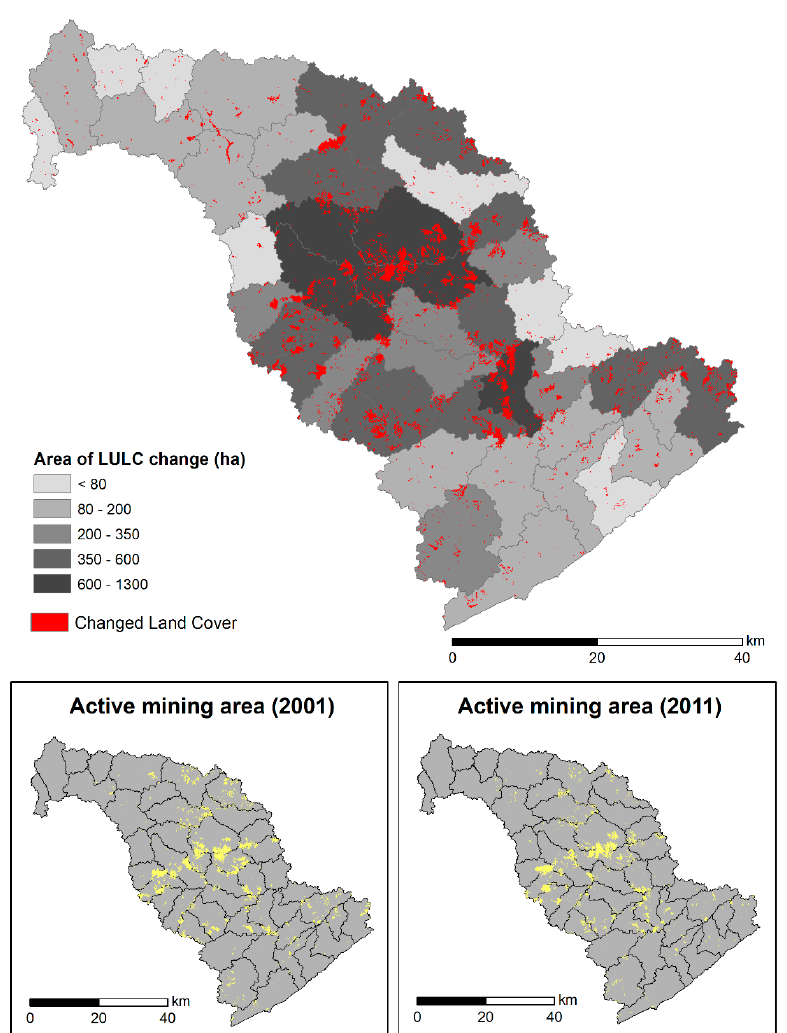
Figure 2. Area of land use land cover (LULC) changes by HUC-12 subwatershed in the NFKR watershed between 2001 and 2011, overlaid with locations of where LULC changes occurred. The two insert maps show the extent of active mining area in 2001 and 2011, respectively based on the published annual mining extent data of Pericak et al. (2018) [34].